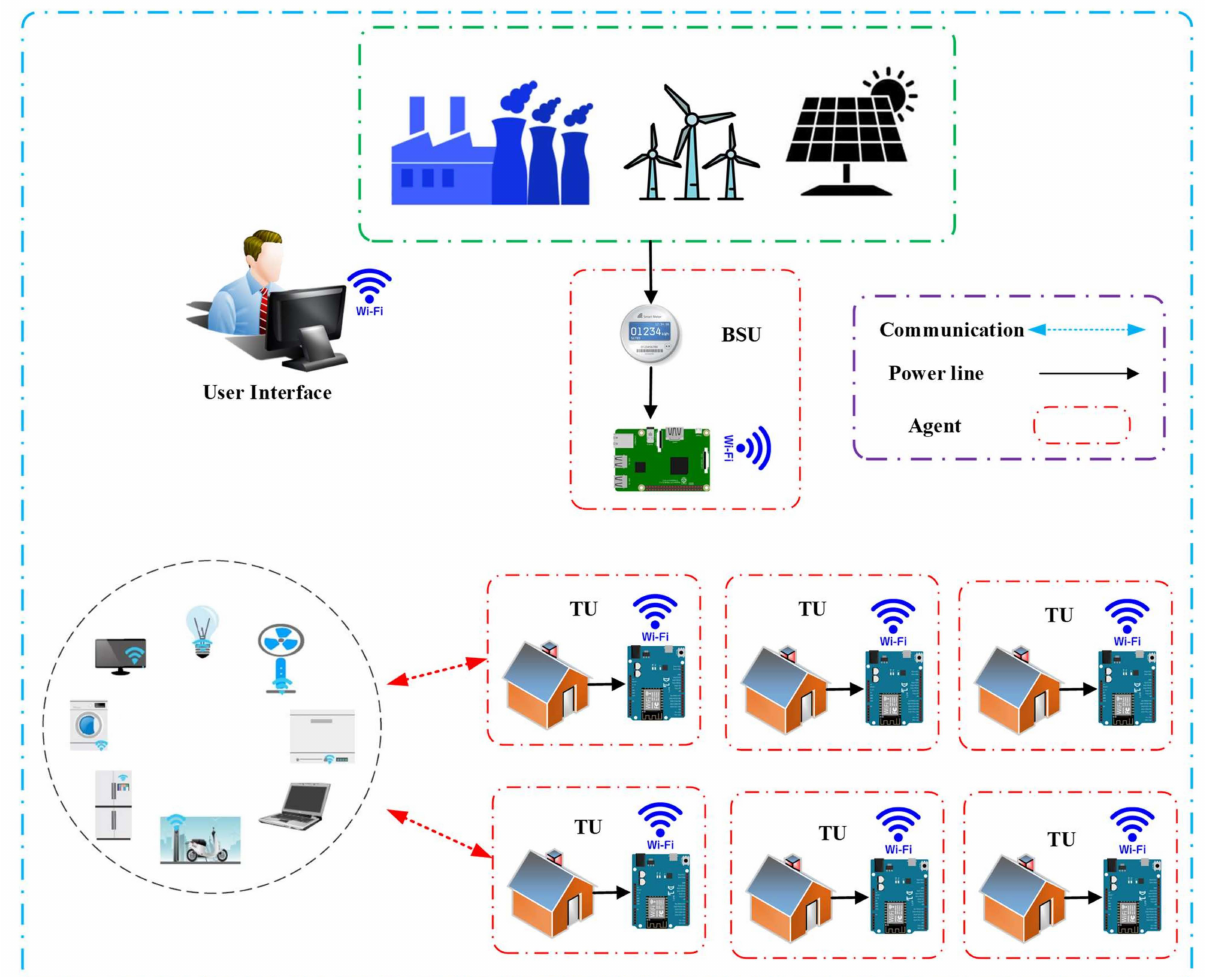
Figure 1. Proposed